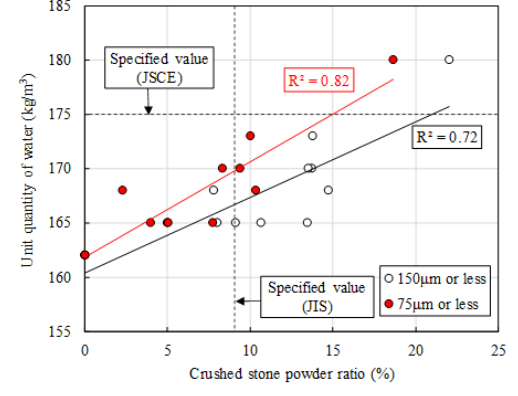
Figure 6. Relationship between crushed stone pow- der ratio and unit quantity of water.